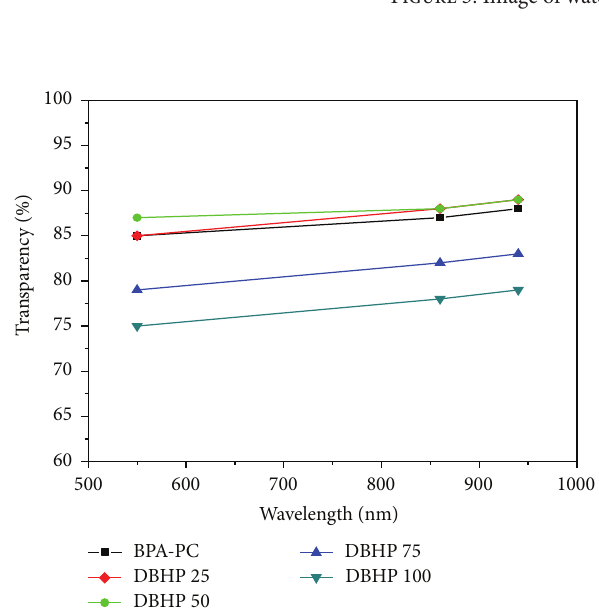
Figure 6: Transparency of